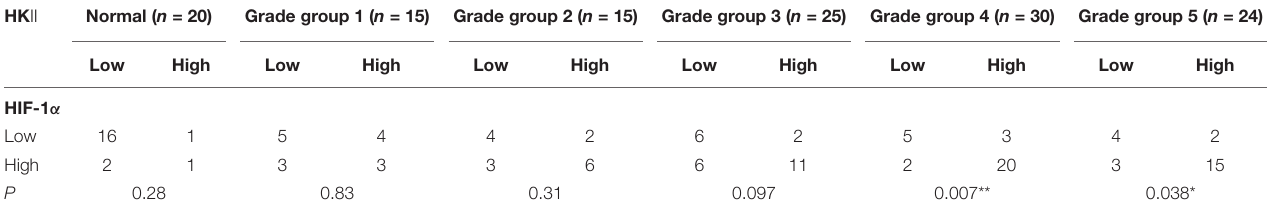
TABLE 4 | Co-relationship of HKII level with HIF-1 α expression in normal prostate tissues and different grade groups of prostate cancer tissues. HK II Normal ( n =